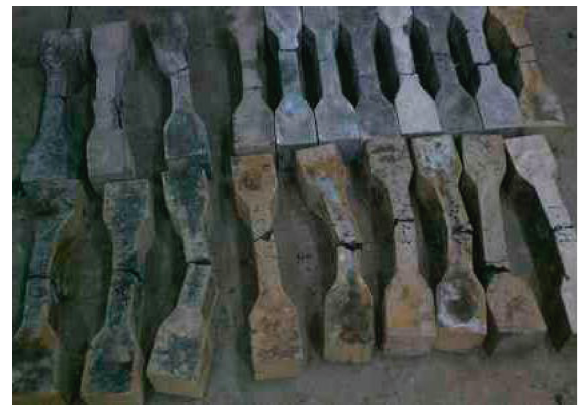
Figure 7: Fractured specimens after the uniaxial tensile